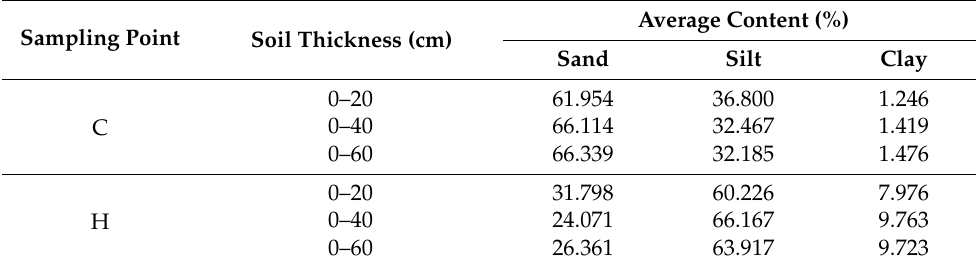
Table 1. Average content of soil particles at different sampling points.